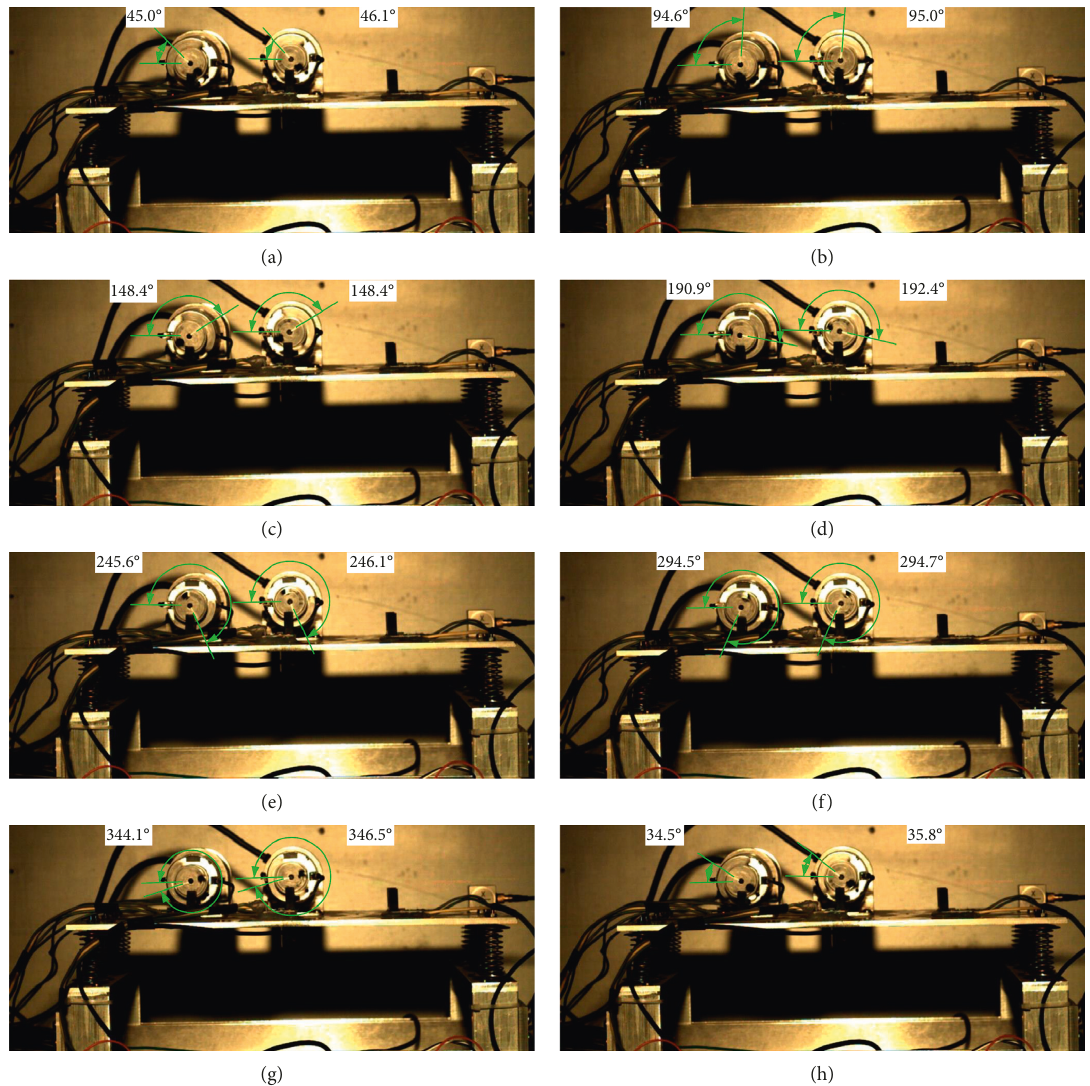
Figure 9: The phase difference of the control synchronization of two ERs with the clockwise rotational direction. (a) φ